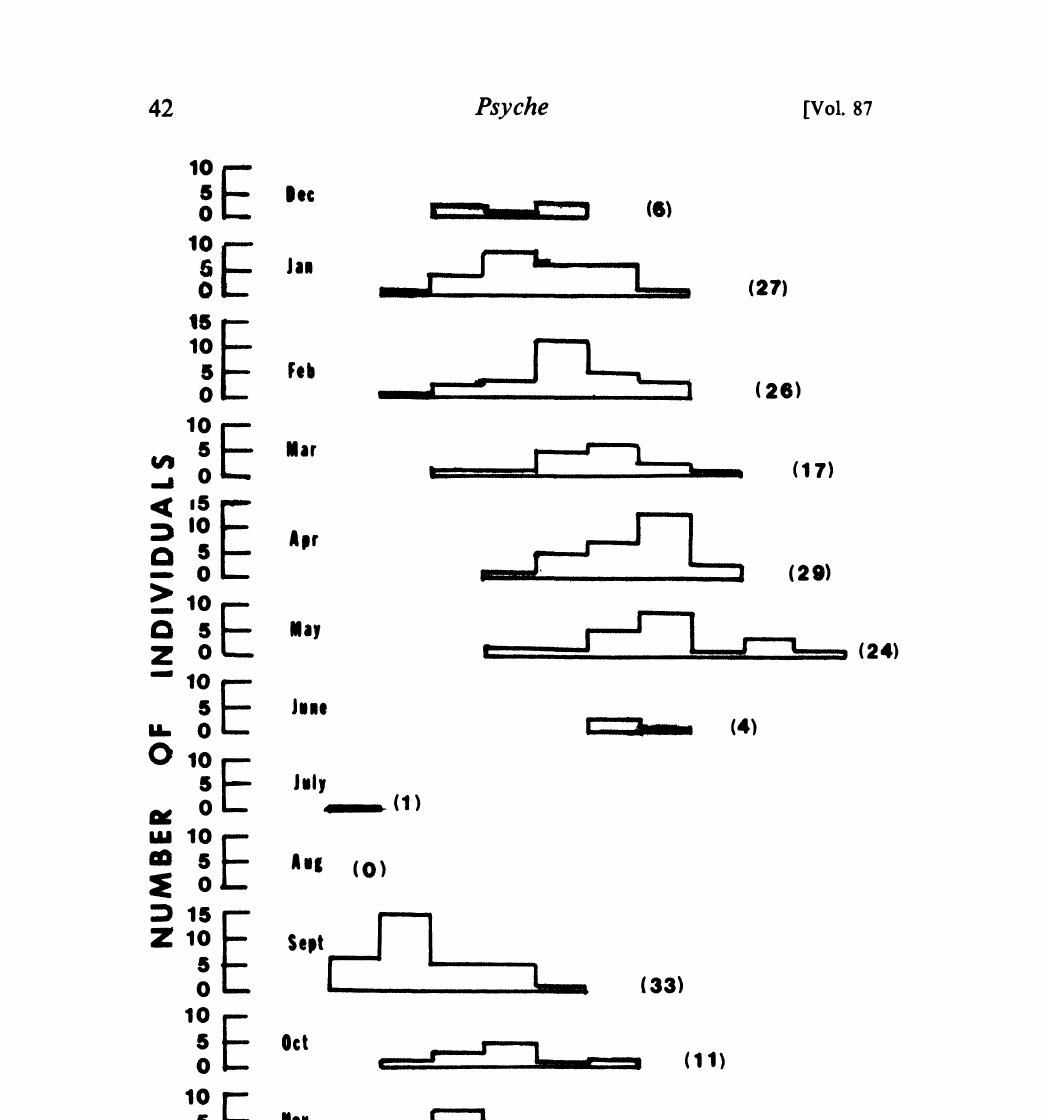
Figure 1. Size-class distribution of nymphs of Baetisca berneri based on body length. The number of individuals each month is in